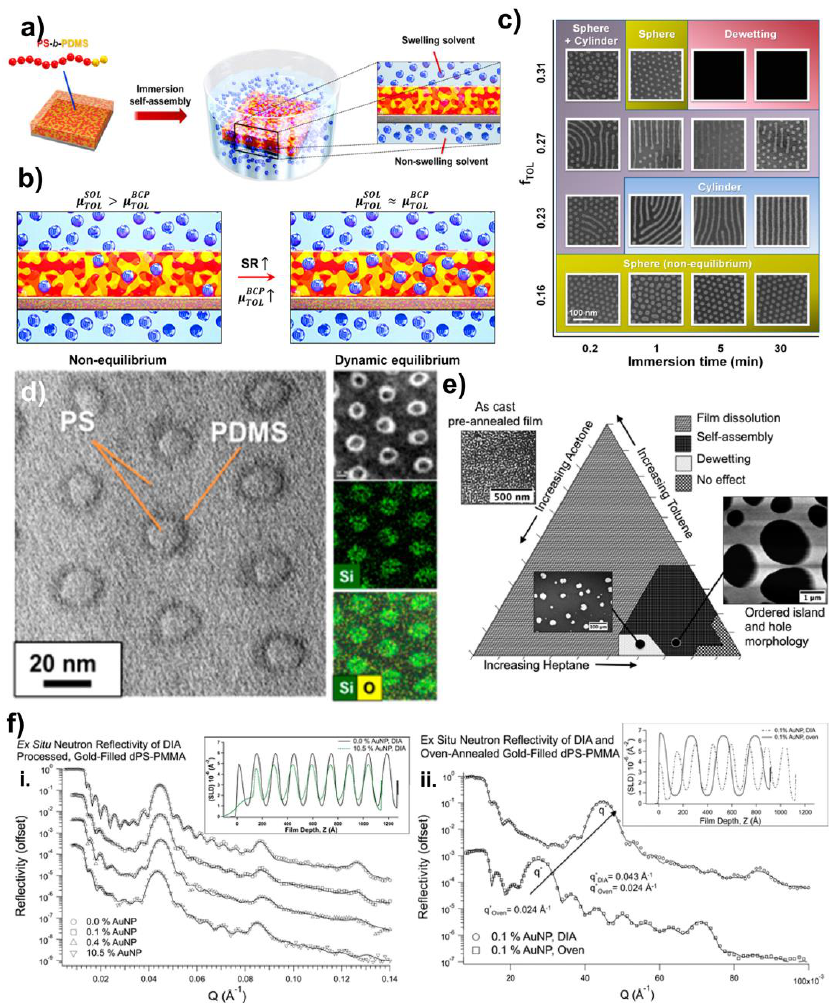
Figure 3. ( a ) Concept of the immersion-induced solvent annealing/direct immersion annealing (DIA) [69] . ( b ) Illustrations of the different swelling states and the comparison of the chemical po- tential inside the film with the increasing swelling ratio [69] . ( c ) Self-assembled morphologies of the PS-b-PDMS BCP treated with different solvent compositions and annealing times [69] . ( d ) For- mation of the core-shell structures during the two-step annealing [69] . ( e ) Ternary phase diagram representing the solvent ratio of the solvent mixture used in direct immersion annealing, based on its effect on the BCP thin film [70] . ( f ) (i – ii) Neutron reflectivity data representing the reduced do- main size of the PS-b-PMMA BCP thin films during direct immersion annealing [70] . Adapted with permission from references [69,70] .